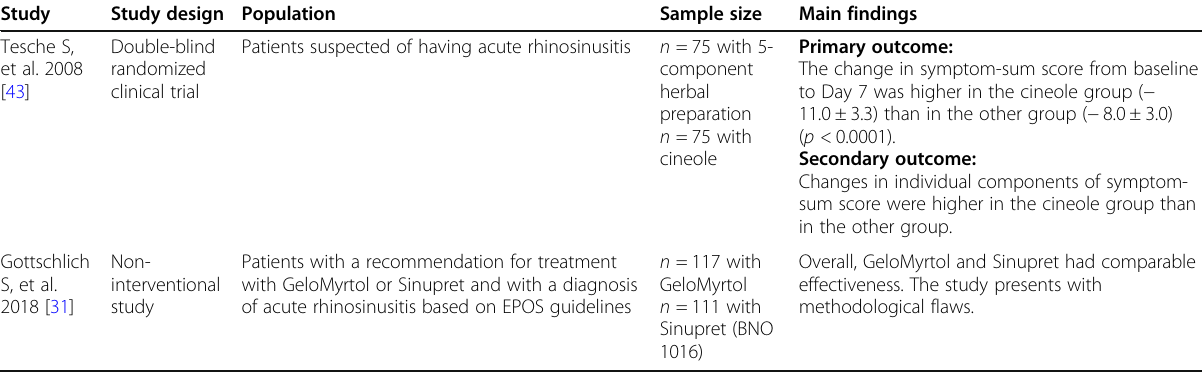
Table 5 Comparative studies of herbal products in acute